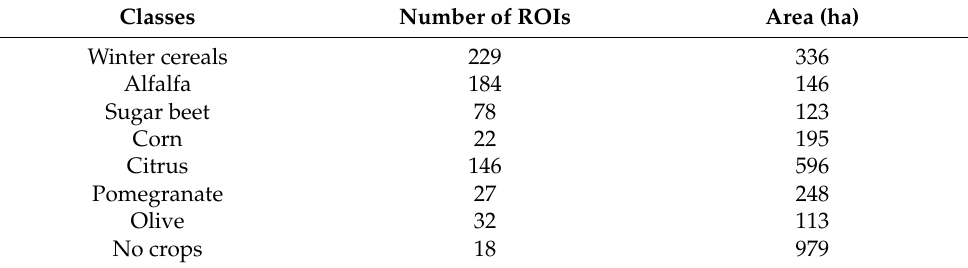
Figure 2. Spatial distribution of the ROIs and the corresponding Sentinel-2 image (False Color Combination: NIR, Red, Green band as RGB), ( A – C ) a detailed zoom. Table 2. Number and area of selected ROIs.